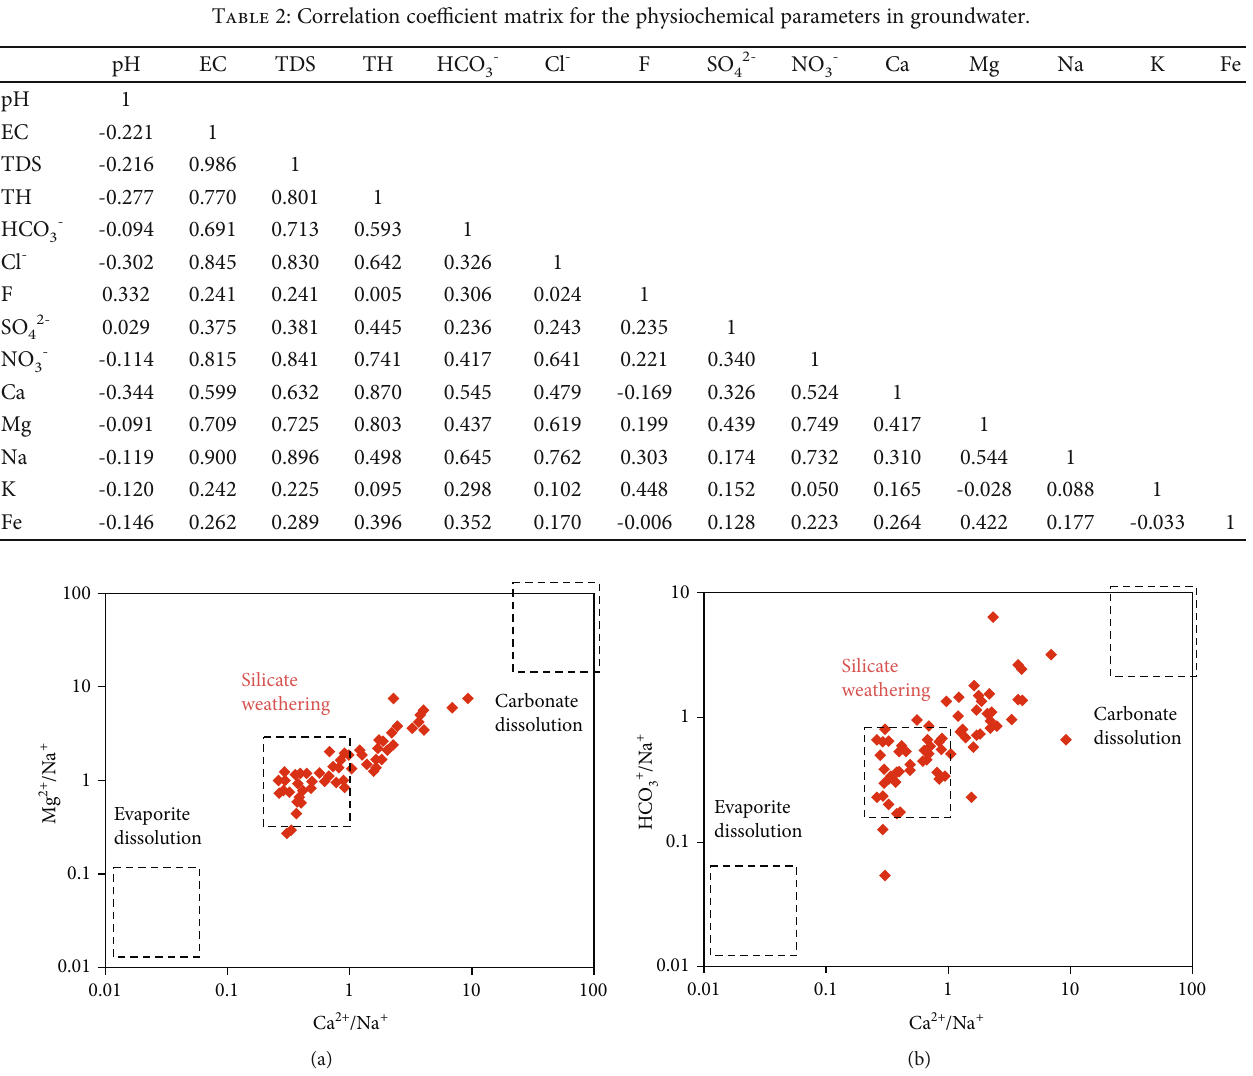
Figure 2: Plots of (a) Na-normalized Ca versus Mg and (b) Na-normalized Ca versus